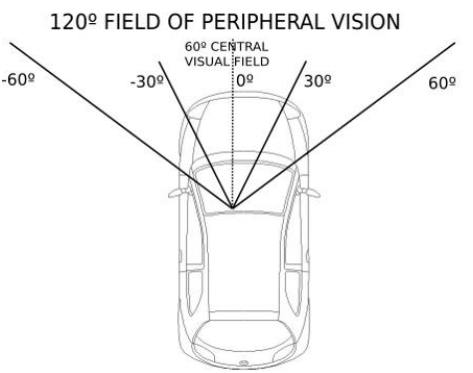
Figure 1. Peripheral vision angle centred in the position of the driver eyes.